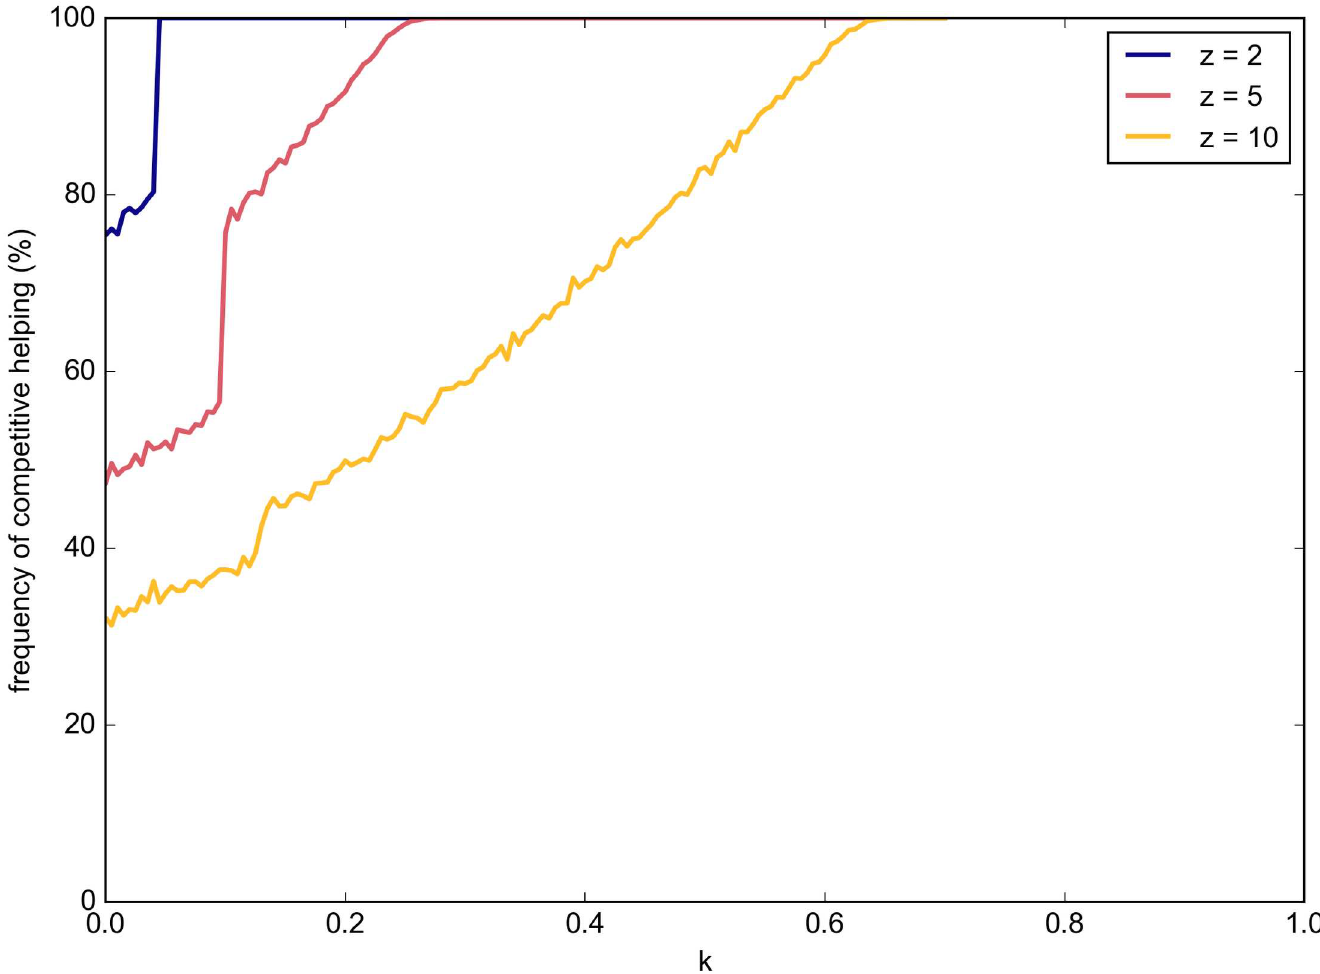
Fig 6. Frequency of resulting competitive helping equilibrium with increasing passive help provided. Small amounts of passive help, k , force competition between